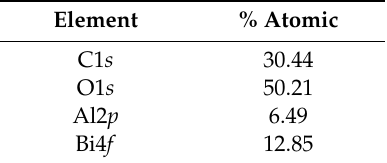
Table 2. Atomic concentration of the regions detected by XPS.